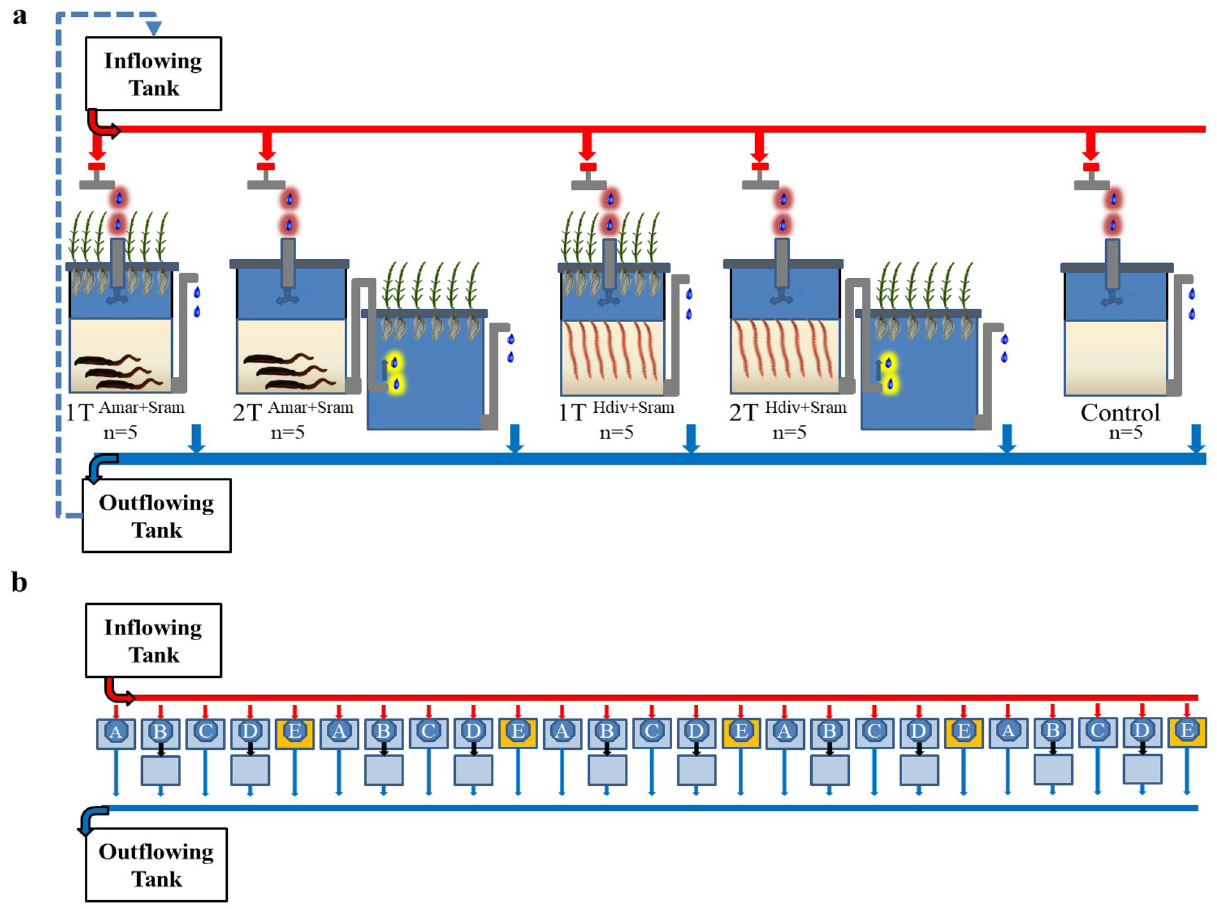
Figure 9. Schematic representation (1a) and distribution (1b) of different IMTA designs tested in the present study using as extractive species polychaetes ( Arenicola marina —Amar—and Hediste diversicolor —Hdiv) and halophytes ( Salicornia ramosissima —Sram) cultured in the same tank (1 T—designs A and C) or in two separate tanks (2 T—designs B and D): (A) 1 T Amar + Sram; (B) 2 T Amar + Sram; (C) 1 T Hdiv + Sram; (D) 2 T Hdiv + Sram; and (E) control tanks with no extractive